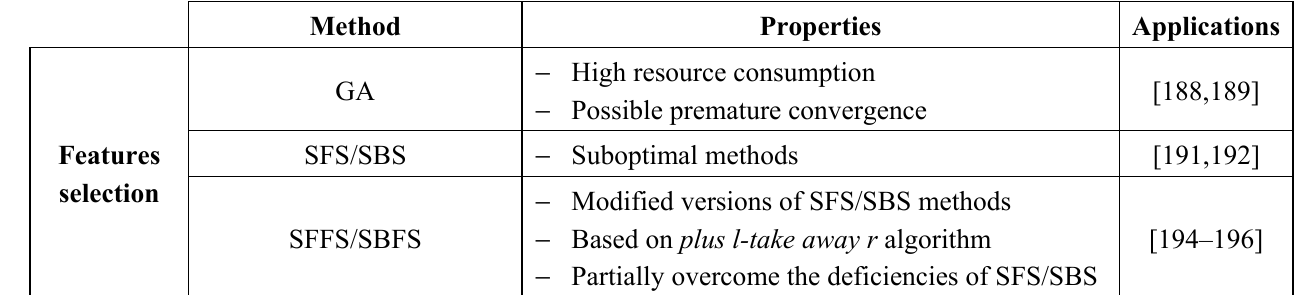
Table 7. Summary of feature extraction